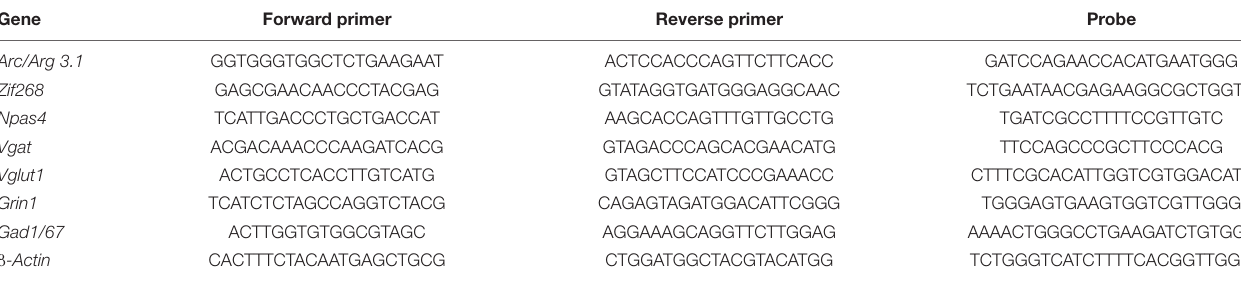
TABLE 1 | Sequences of forward and reverse primers and probes used in real-time PCR analyses. Gene Forward primer Reverse primer Probe Arc/Arg